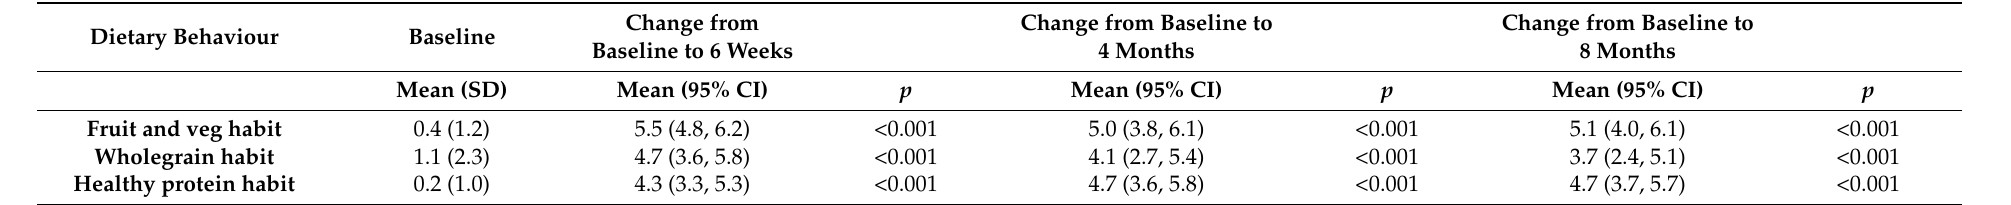
Table 5. Mean change in specific automaticity scores for individually tailored planned dietary behaviours within the intervention group. Dietary